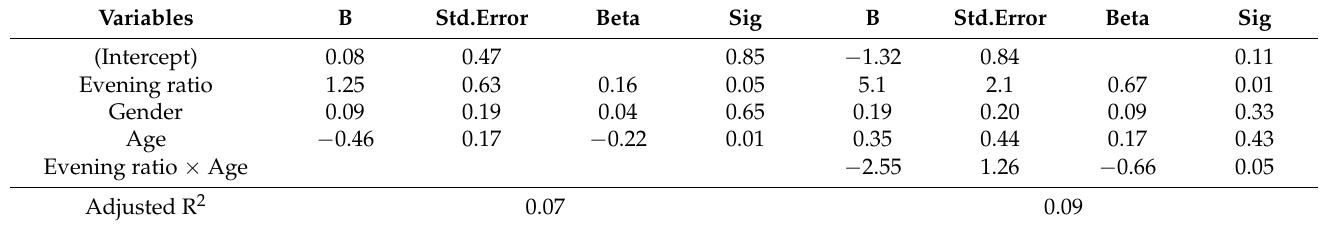
Table 6. Linear Regression model. Dependent variable: Cognitive-affective depression.